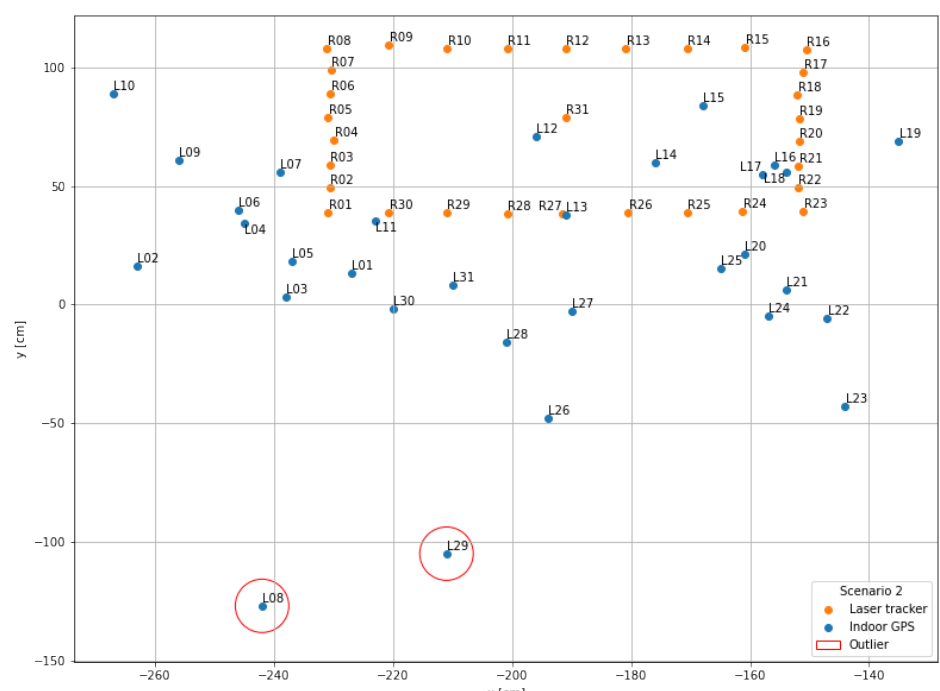
Figure 10. Data visualization scenario 2: Three lines of